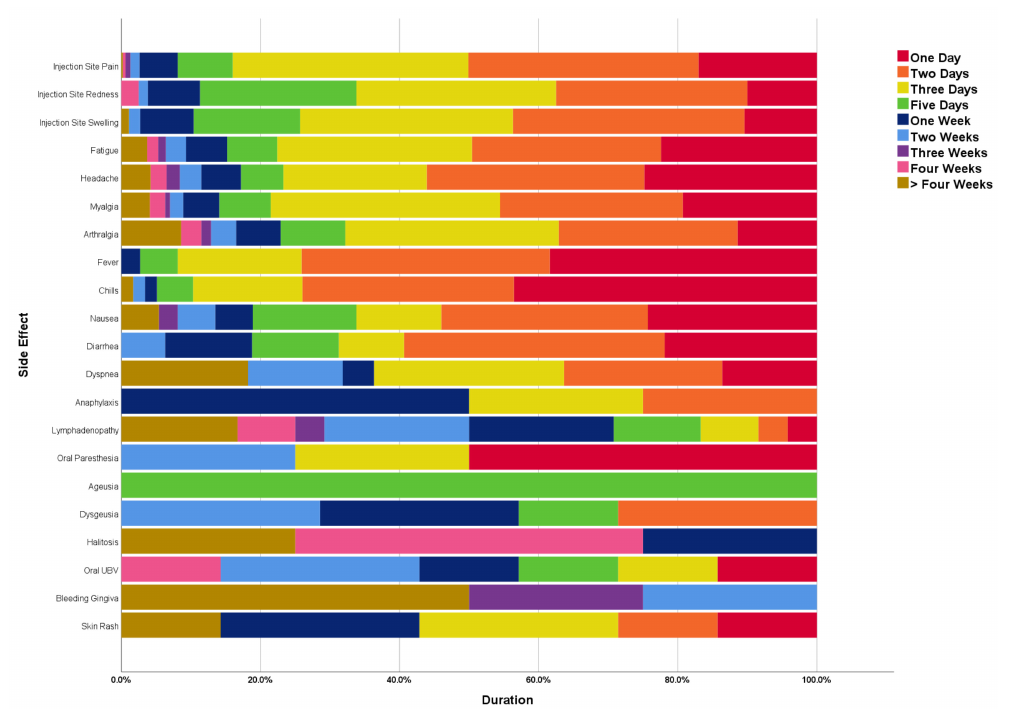
Figure 2. Duration of COVID-19 Side Effects Experienced by Saudi Healthcare Workers Responding to CoVaST-SA, (n =